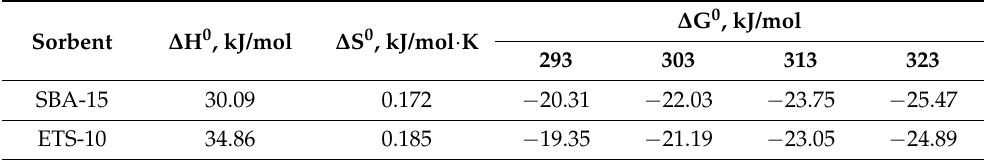
Table 4. Thermodynamic parameters of the sorption process.